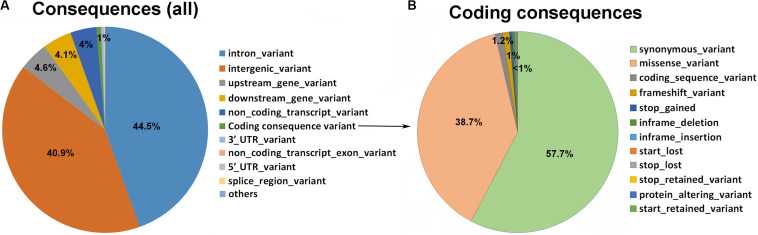
Statistics regarding the variant types of the goat whole genome using VEP Ensemble gene annotation. (A) Pie plot of the total variant annotation. (B) Pie plot of the coding consequence variant annotation.